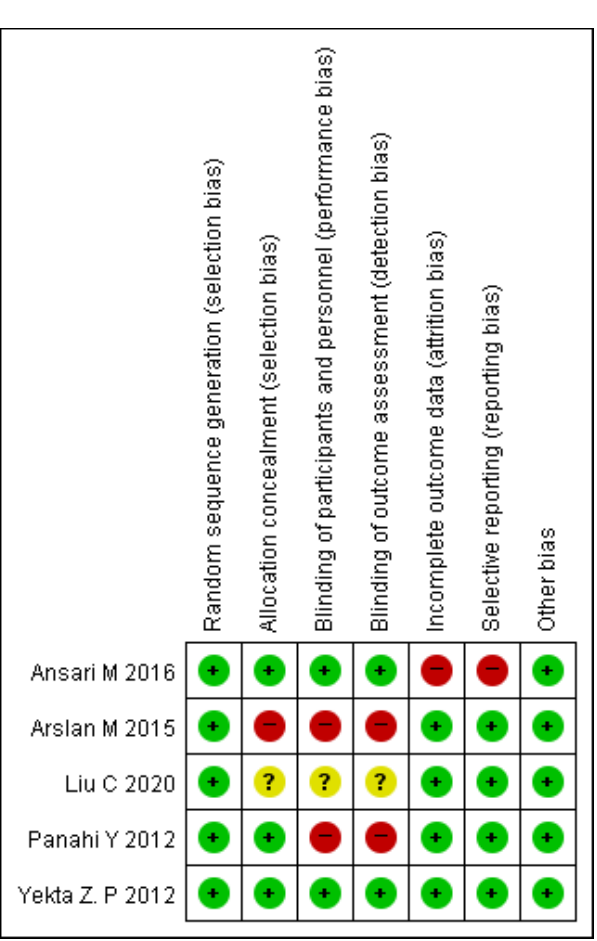
Figure 2. Risk of bias associated with included trials [23–27].